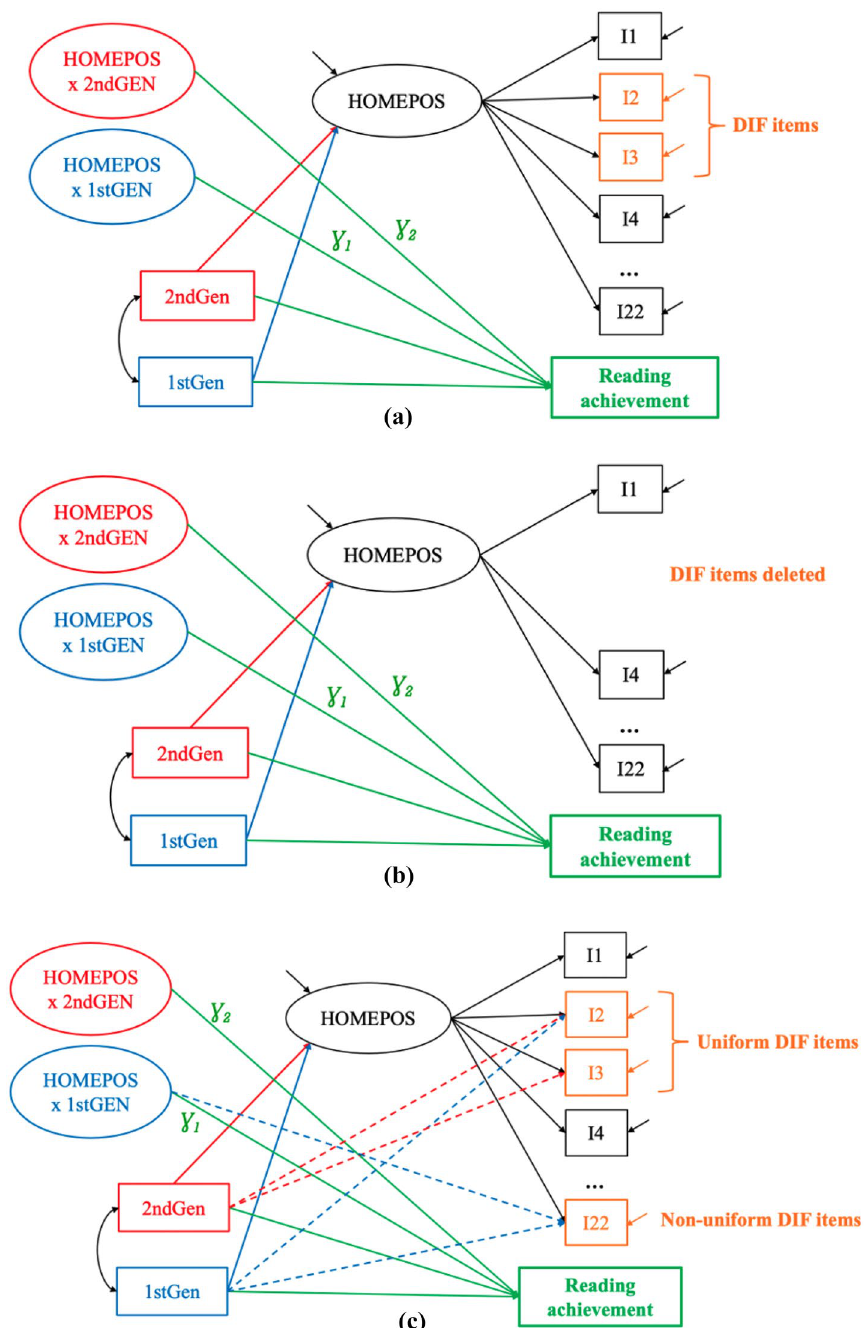
Fig. 2 DIF treatment approaches when quantifying the HOMEPOS–reading achievement relationship: a ignoring DIF; b deleting DIF items; c accounting for DIF. In this example, item I2 exhibited uniform DIF across 2ndGEN, 1stGEN and the reference groups; item I3 exhibited uniform DIF only between 2ndGEN and the reference group; item I22 exhibited non-uniform DIF between 1stGEN and the reference group. Ɣ 1,2 —the moderation effect of “HOMEPOS 2ndGEN/1stGEN”. This allows us to report the HOMEPOS–reading × achievement relationship for each